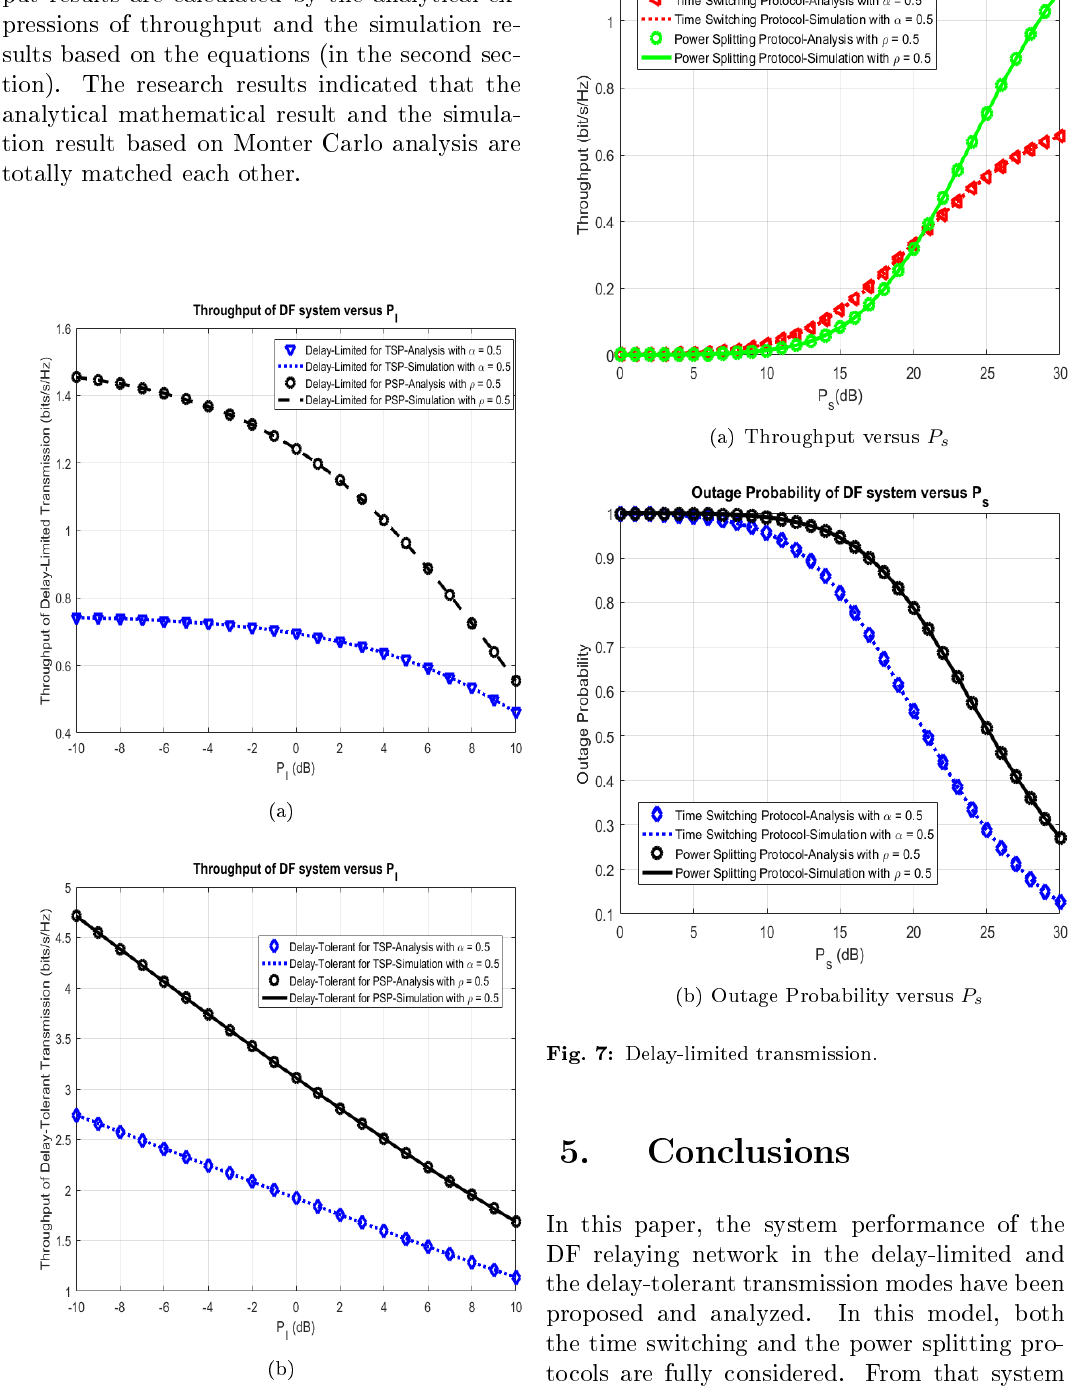
Fig. 6: Throughput of DF system versus P I